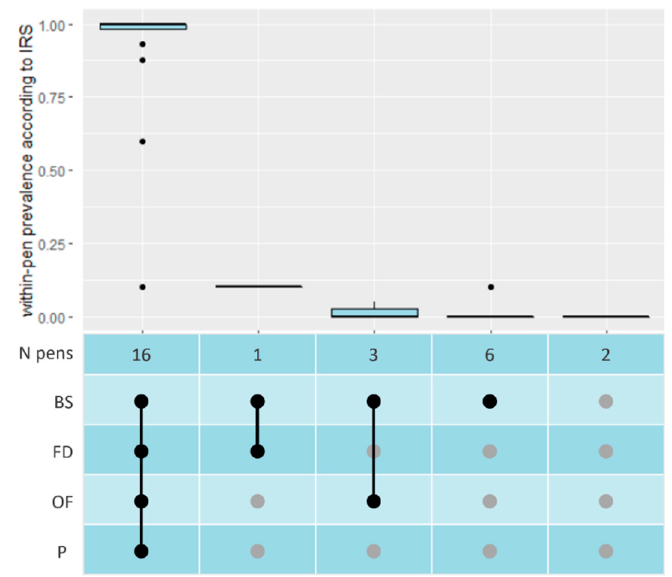
Figure 2. Within-pen prevalence according to IRS, for all combinations of positive tests for the four sample types. (N = number of, IRS = Individual Rectal Swabs, BS = Boot Sock, FD = Faecal Dropping, OF = Oral Fluid, P = Pooled Individual Rectal Swabs, ● = positive PCR test, ● = negative PCR test). Table 2. Posterior estimation of sensitivity, specificity of four pen-level sampling methods and of prevalence per age group, according to a Bayesian LCA with minimally informative priors and conditional independence between sampling methods (PCI = posterior credibility interval, BS = boot sock, FD = faecal dropping, P = pool of individual rectal swabs, OF = oral